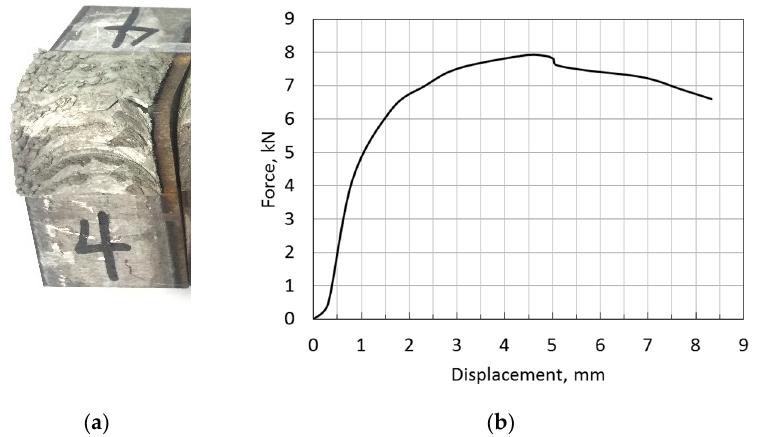
Figure 22. Bending test for sample 4: ( a ) sample; ( b ) force-displacement curve.